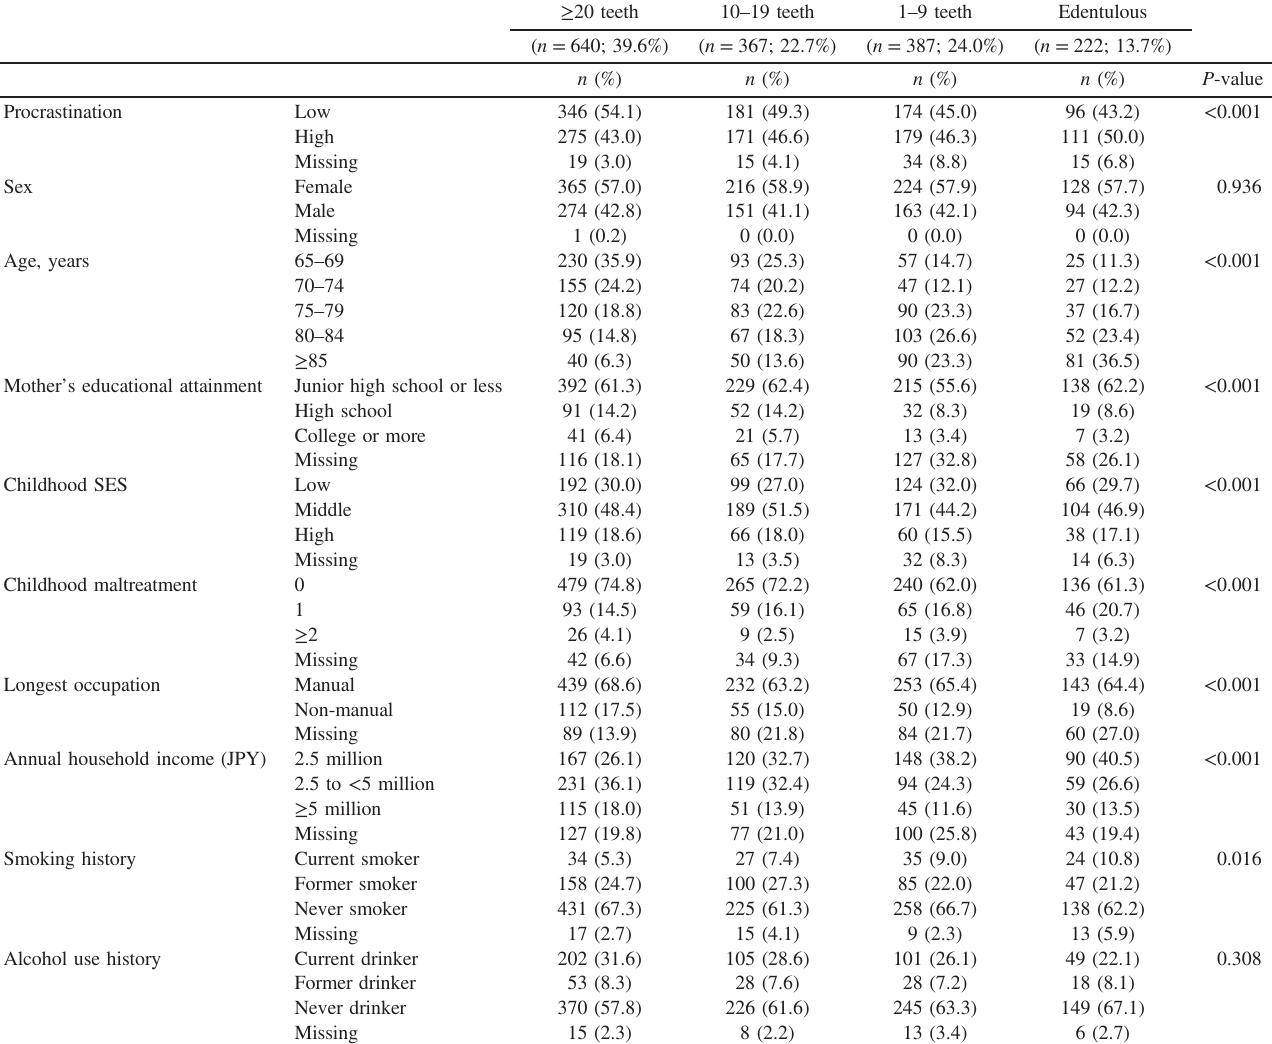
Table 1. Participant demographic characteristics and the number of remaining teeth ( N = 1,616)